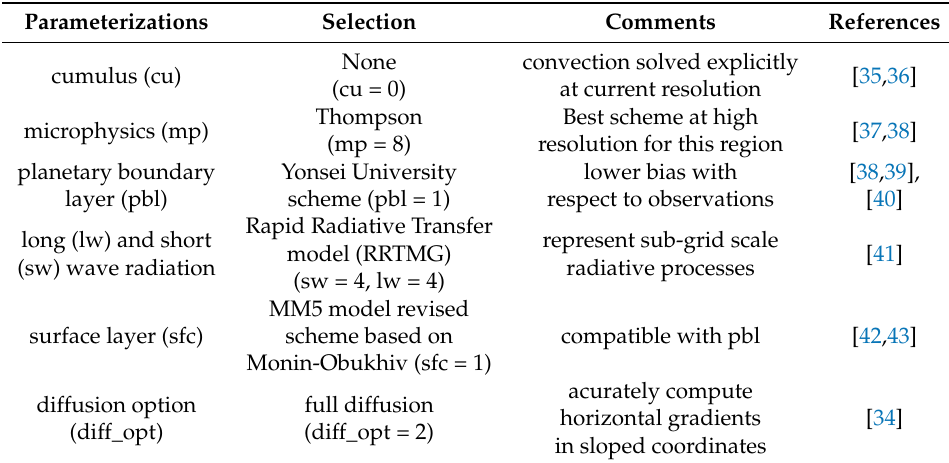
Table 2. Dynamical and physical parameterizations